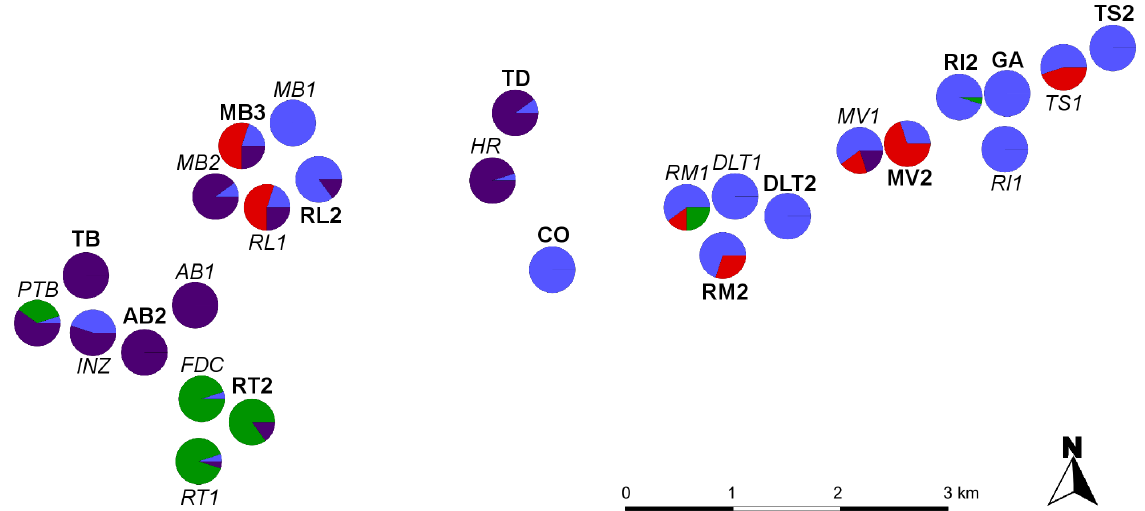
Figure 5. Map of the sampled recent populations (italics) and old populations (bold) of Origanumvulgare . Pie slices correspond to population membership to the four genetic groups defined by the Bayesian assignment analysis of Structure [55]. Group 1: blue, group 2: red, group 3: green, group 4: purple. Population codes correspond to those in table 1.